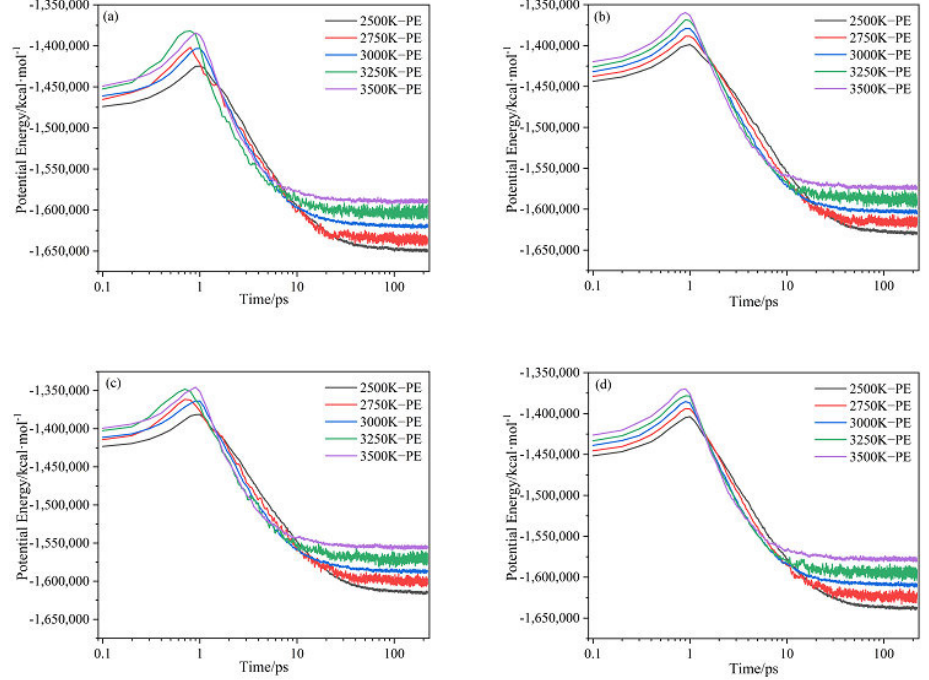
Figure 3. Evolution of potential energy of ( a ) CL-20/H 2 O, ( b ) CL − 20/CO 2 , ( c ) CL − 20/N 2 O, ( d ) CL − 20/NH 2 OH system with time at different temperatures. Thick trendline corresponds to the actual concentration data of corresponding matching color. 20/N 2 O, (d) CL-20/NH 2 OH system with time at different temperatures is shown in Figure curves for CL-20/CO 2 and CL-20/NH 2 OH is very similar. That is, the incorporation of N 2 O